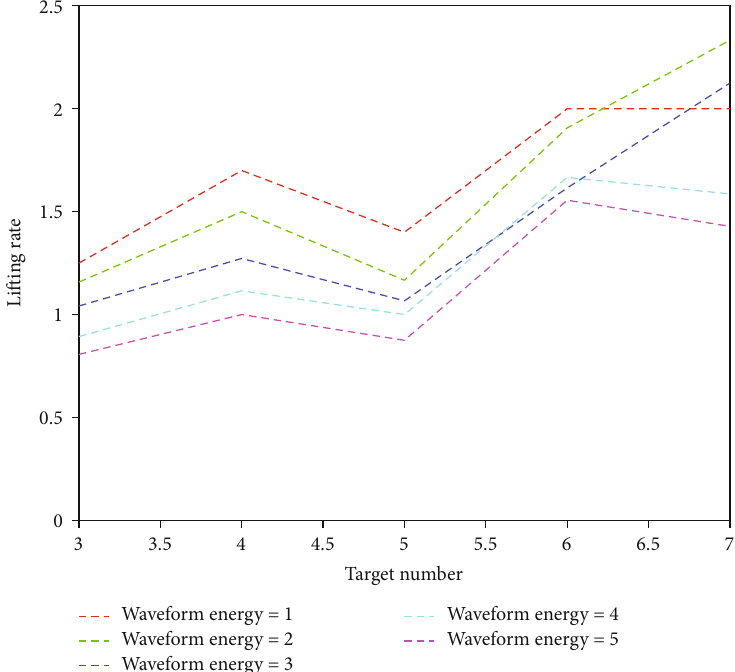
Figure 12: The relationship between the relative lifting rate and the number of targets in the situation of equal probability